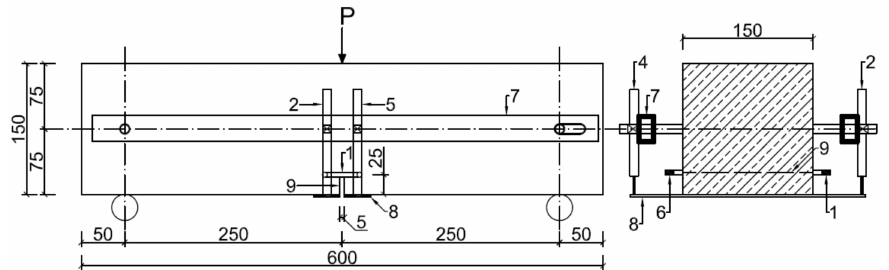
Figure 2. Test setup project: 1 and 6—sensors for measuring notch opening width (CTOD), 2–5—sensors for measuring deflection measurement ( δ ), 7—aluminum profile, 8—aluminum flat bar, and 9—notch.